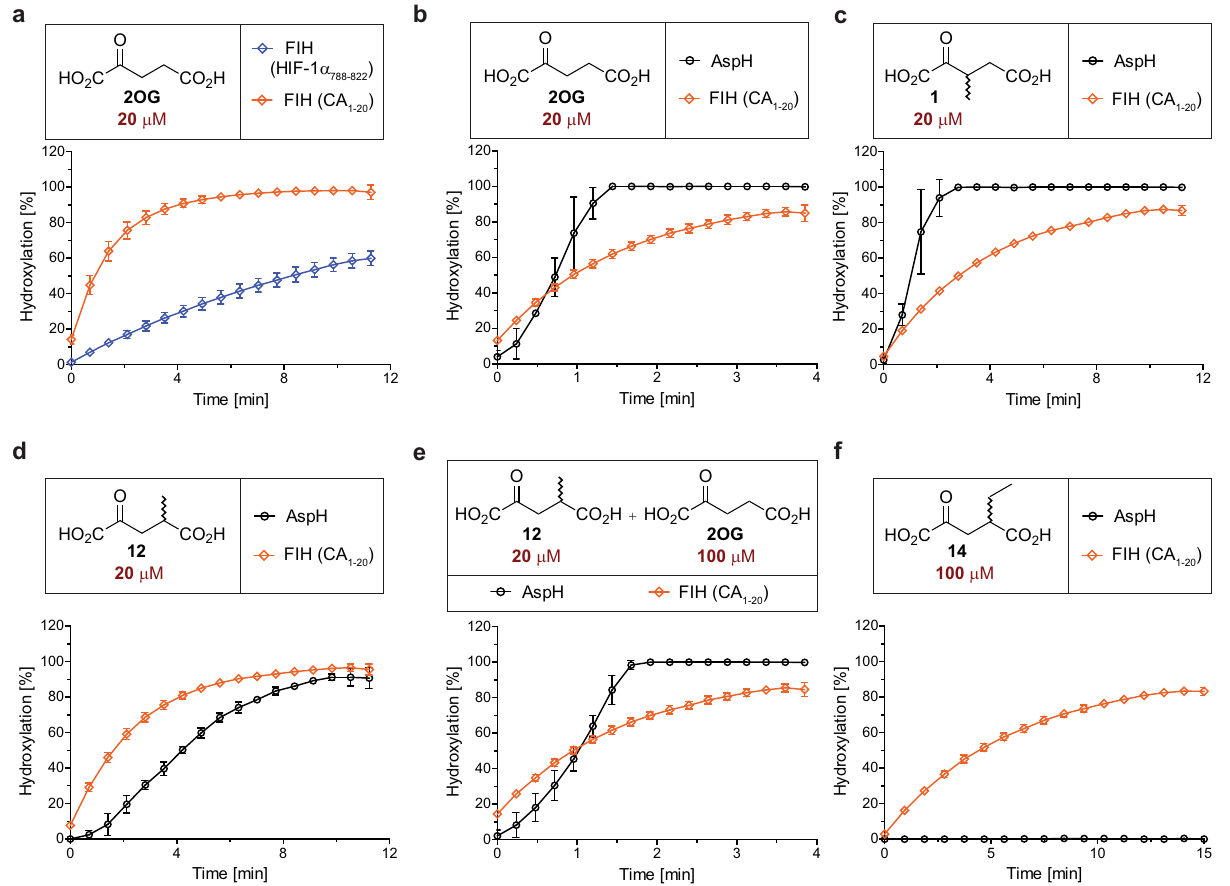
Fig. 2 2OG derivatives selectively sustain the catalytic activities of 2OG oxygenases in vitro. Assays were performed as described in the Methods section using 0.15 μ M of each 2OG oxygenase (diamond: FIH, circle: AspH) and 5.0 μ M of each substrate (blue: HIF-1 α 788 – 822 37 ; orange: CA 1 – 20 47 ; black: hFX-EGFD1 86 – 124 – 4Ser 27,31 , AspH substrate) in the presence of 100 μ M LAA, 10 μ M FAS, and the indicated concentration of cosubstrate in buffer (50 mM Tris, 50 mM NaCl, pH 7.5). Mean of three independent runs ( n = 3; mean ± SD). Measurement times were normalized to the fi rst sample injection analyzed after the addition of the 2OG oxygenase to the Substrate Mixture ( t = 0 min), by which time low levels of hydroxylation were manifest. Cosubstrates: a 20 μ M 2OG; b 20 μ M 2OG; c 20 μ M 1 ; d 20 μ M 12 ; e 20 μ M 12 and 100 μ M 2OG; f 100 μ M 14 . Source data are provided as a Source Data fi